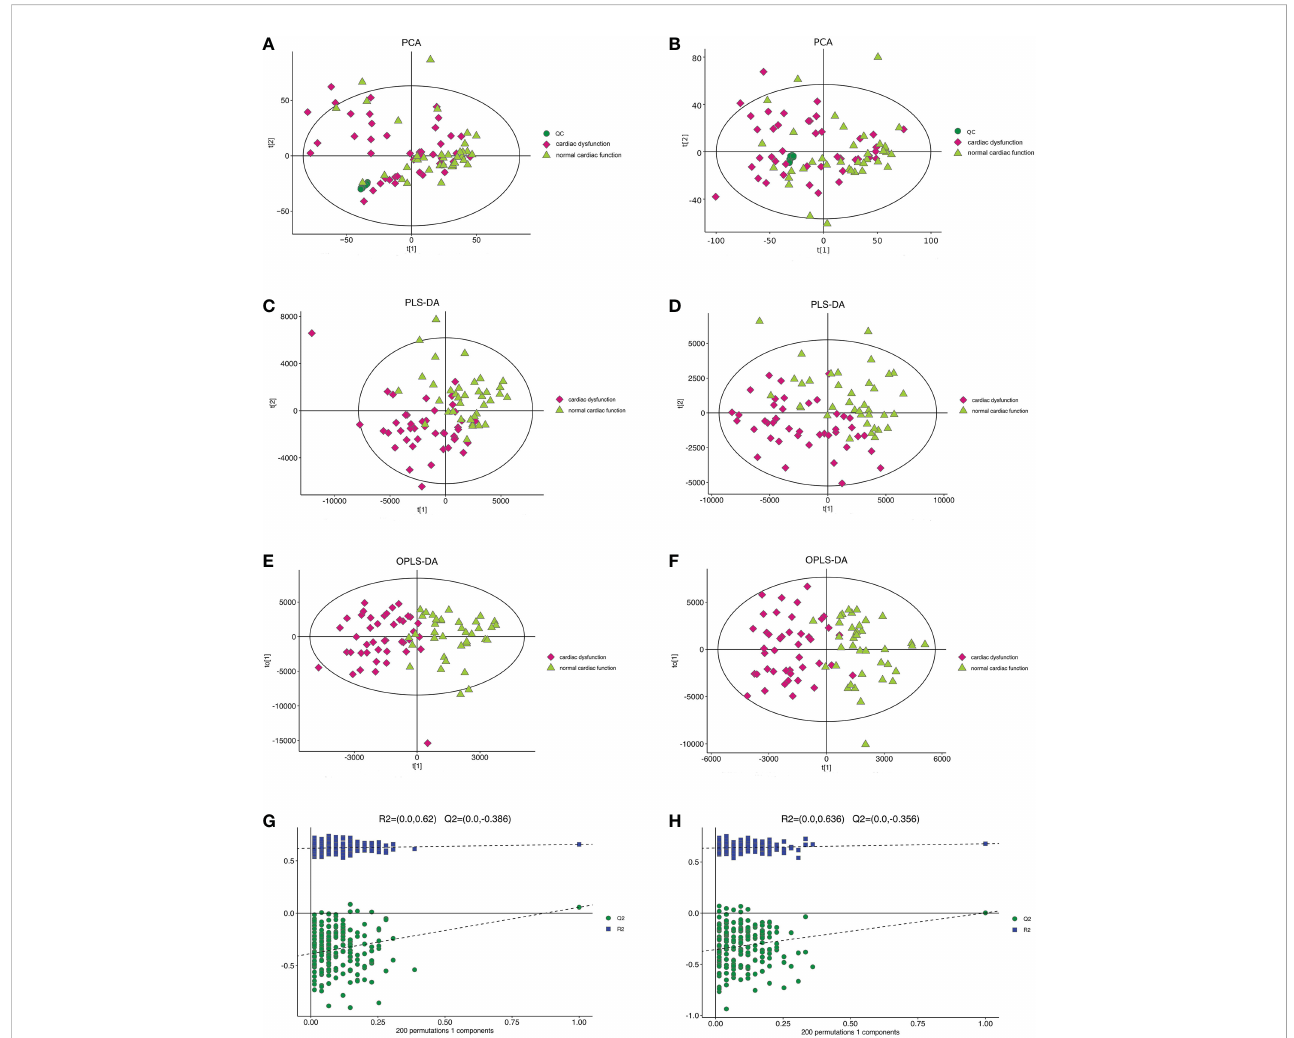
FIGURE 2 The multidimensional results in positive and negative ionization mode in total patients. (A) PCA score plot in positive ionization mode [R 2 X (cum) = 0.519, Q 2 (cum) = 0.442]. (B) PCA score plot in negative ionization mode [R 2 X (cum) = 0.502, Q 2 (cum) = 0.439]. (C) PLS-DA score plot in positive ionization mode [R 2 X (cum) = 0.219, R 2 Y (cum) = 0.756, Q 2 (cum) = 0.563]. (D) PLS-DA score plot in negative ionization mode [R 2 X(cum) = 0.249, R 2 Y(cum) = 0.778 Q 2 (cum) = 0.595]. (E) OPLS-DA score plot in positive ionization mode [R 2 X (cum) = 0.219, R 2 Y (cum) = 0.756, Q 2 (cum) = 0.459]. (F) OPLS-DA score plot in negative ionization mode [R 2 X(cum) = 0.249, R 2 Y(cum) = 0.778 Q 2 (cum) = 0.398]. (G) Permutation test in positive ionization mode (R 2 = 0.620, Q 2 = -0.386). (H) Permutation test in negative ionization mode (R 2 = 0.636, Q 2 = -0.356). PCA, principal component analysis; PLS-DA, partial least squares discrimination analysis; OPLS-DA, orthogonal partial least squares-discriminant